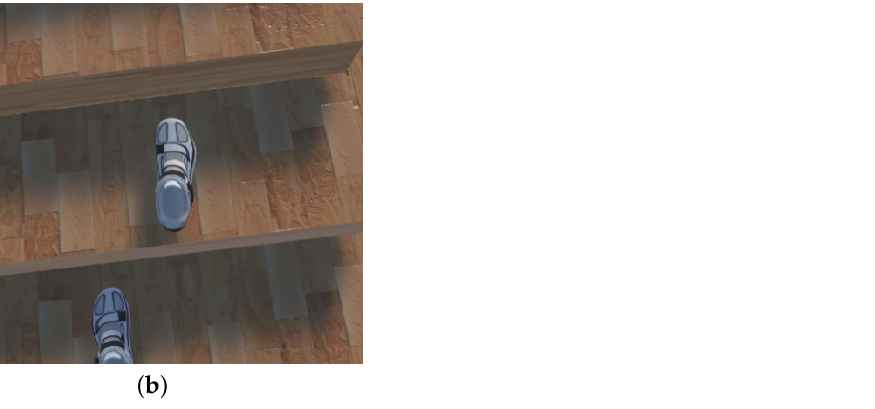
Figure 3. Configuration of the visual display part: ( a ) details of the system presenting the virtual environment and ( b ) image displayed on the HMD.